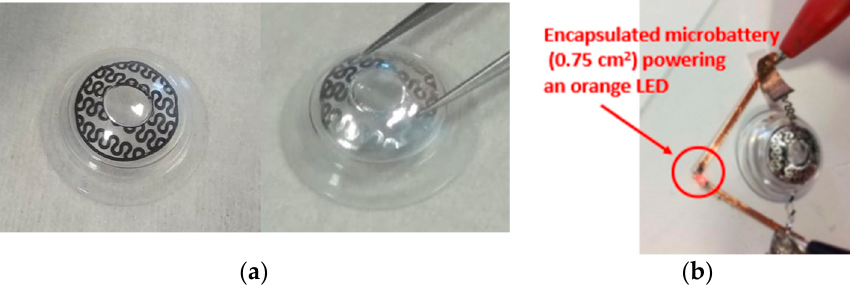
Figure 4. Flexible laser patterned LNMO electrode ( a ), prototype 0.75 cm² ring micro-battery powering a LED ( KPG-1608SEKC-T from Kingbright™ emitting @ 610 nm) ( b ).